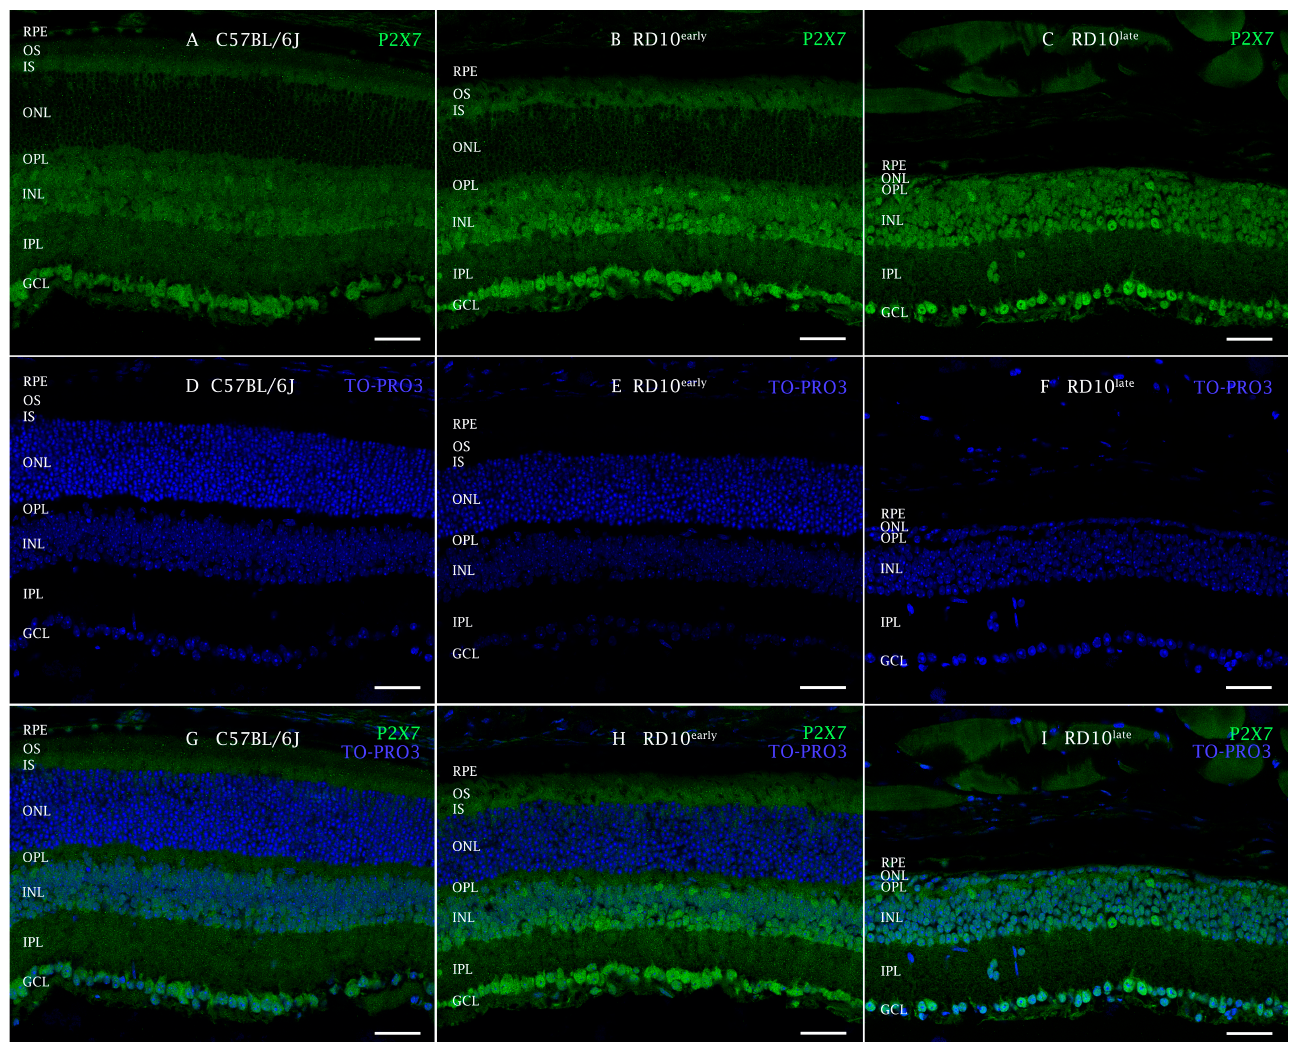
Figure 3. P2X7R expression in mouse retinas analyzed by immunohistochemistry. Cross-sectional cryosections of retinas from a representative C57BL/6J mouse ( A , D , G ) and rd10early ( B , E , H ) and rd10late ( C , F , I ) mice, stained with antibodies against P2X7R ( A – C , G – I ). Nuclei were stained with TO-PRO ( D – F ). In C57BL/6J mice, immunopositive fluorescence against P2X7R appears mainly located in the INL and GCL. RPE: retinal pigment epithelial cells; OS: outer segments; IS: inner segments; ONL: outer nuclear layer; OPL: outer plexiform layer; INL: inner nuclear layer; IPL: inner plexiform layer; GCL: ganglion cell layer. Scale bar: 50 µ